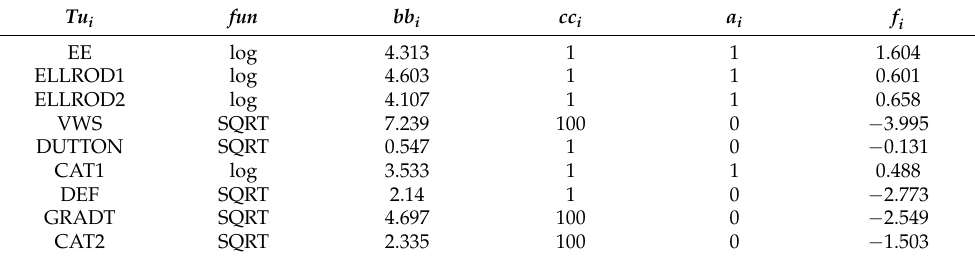
Table 3. Parameters and functions used in the regression for each turbulence indicator in Equation (3). Tu